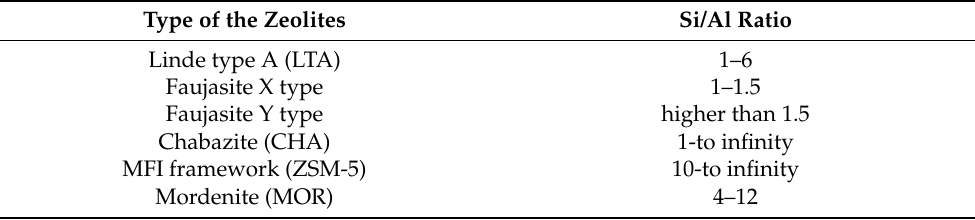
Table 3. The Si/Al ratio of zeolites